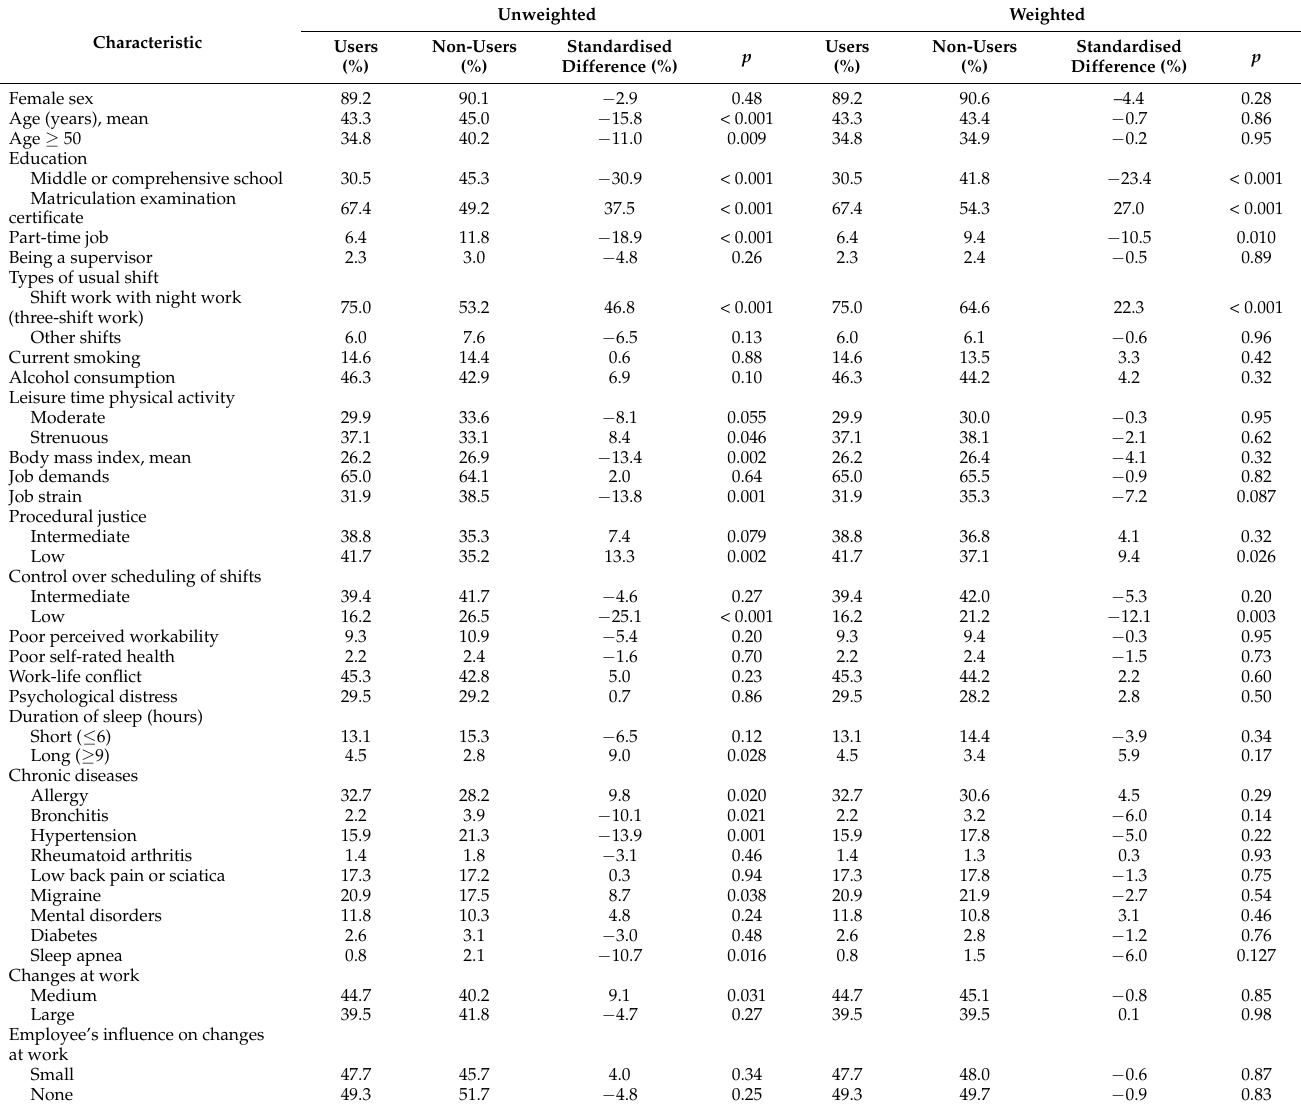
Table 3. Comparison of the baseline characteristics in the unweighted and weighted